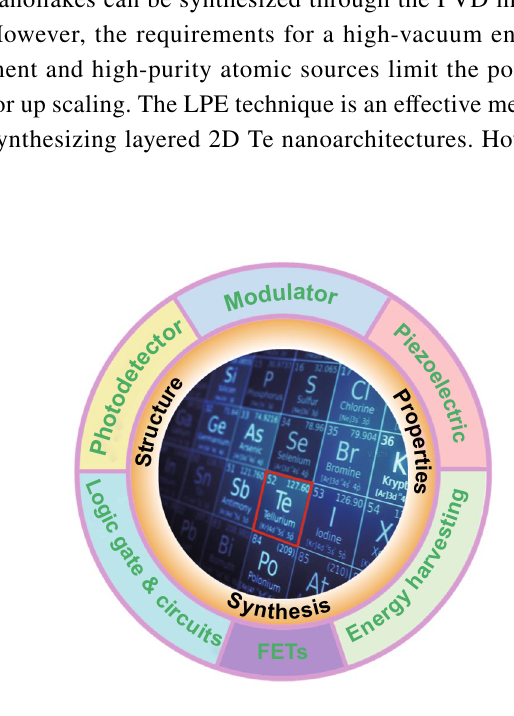
Fig. 18 The academic and engineering applications of 2D Te nano‑